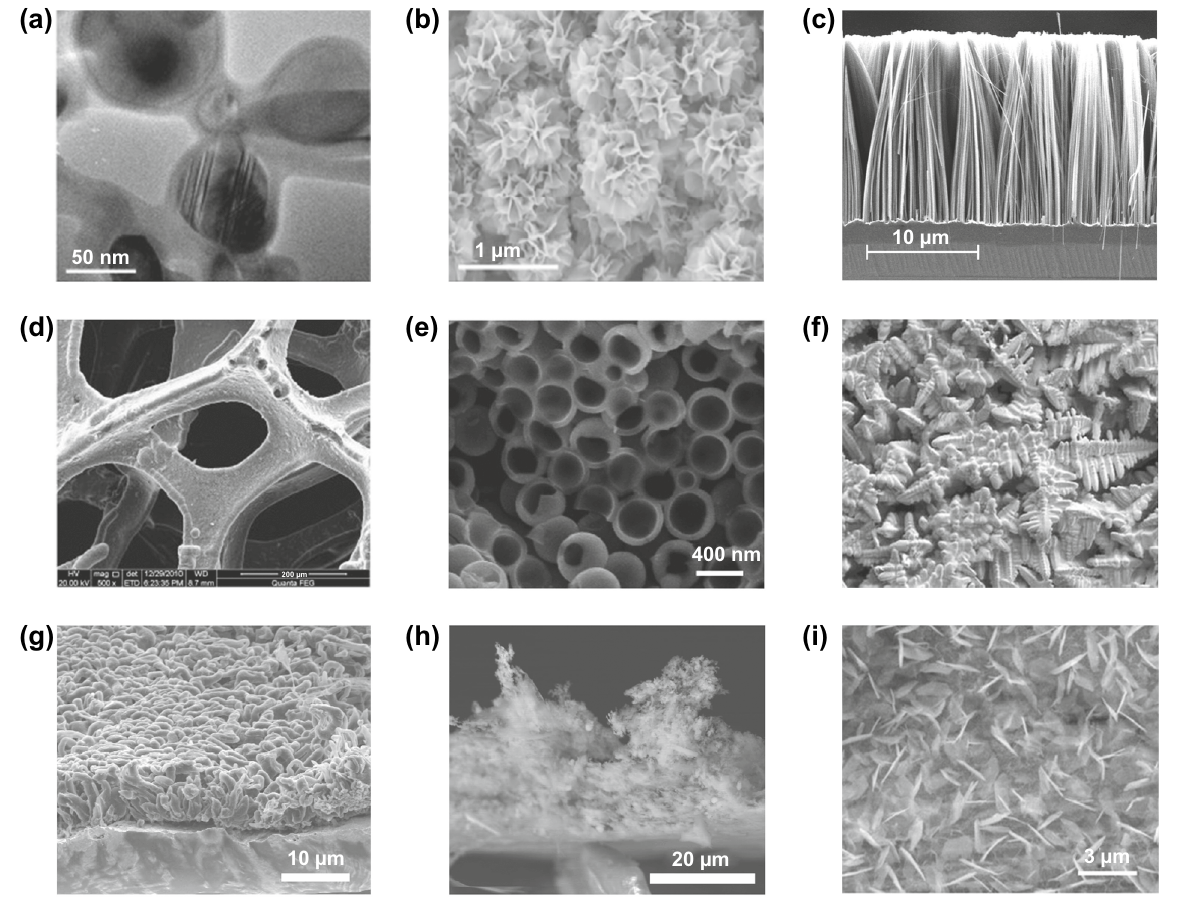
Fig. 11 Scanning electron micrographs showing various, selected nanostructured silicon anodes. a core–shell silicon-carbon nanoparticles [147]. Copyright 2012, Elsevier. b Spongy nanographene encapsulating silicon nanoparticles [149] . Copyright 2017, Springer Nature. c Aligned silicon nanowires [152] . Copyright 2008, AIP Publishing. d Silicon thin film deposited on nickel foam [153] . Copyright 2012, Elsevier. e 3D porous anode formed from hollow silicon nanospheres permission [154] . Copyright 2011, American Chemical Society. Scanning electron micro- graphs showing various dendrite morphologies. f Melt-grown crystal dendrites [155] . Creative Commons License (CC BY). g Electrochemically grown lithium dendrites [156] . Copyright 2016, American Chemical Society. h Electrochemically grown aluminium dendrites [157]. Copyright 2017 , American Chemical Society. i Electrochemically grown zinc dendrites [158] . Copyright 2020, John Wiley and